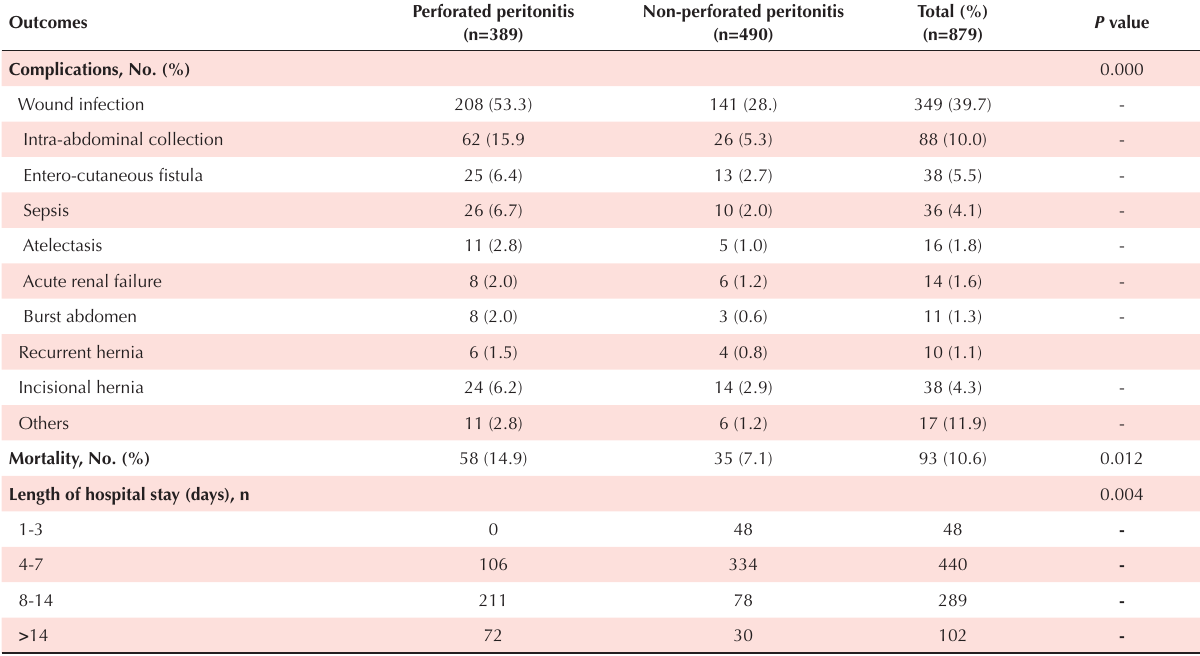
Table 4. Post-operative outcomes Outcomes